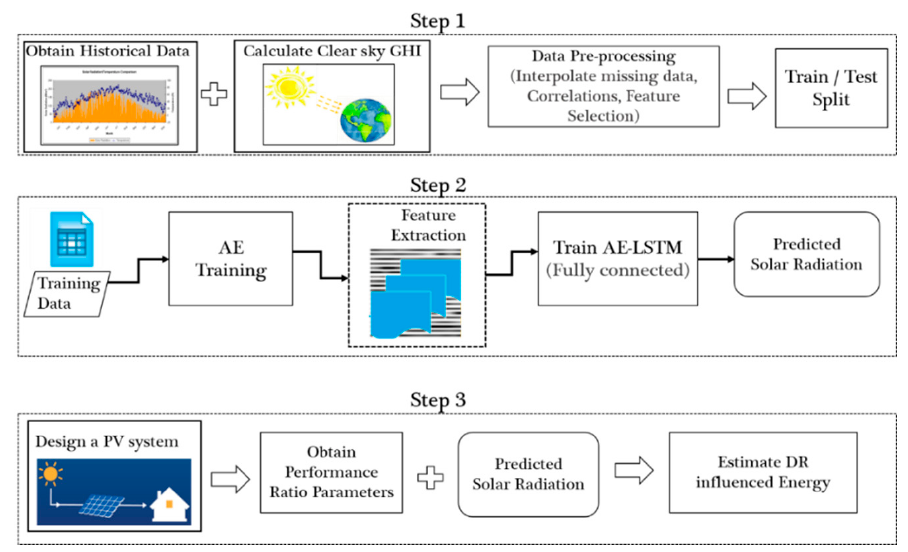
Figure 1. The proposed methodology.